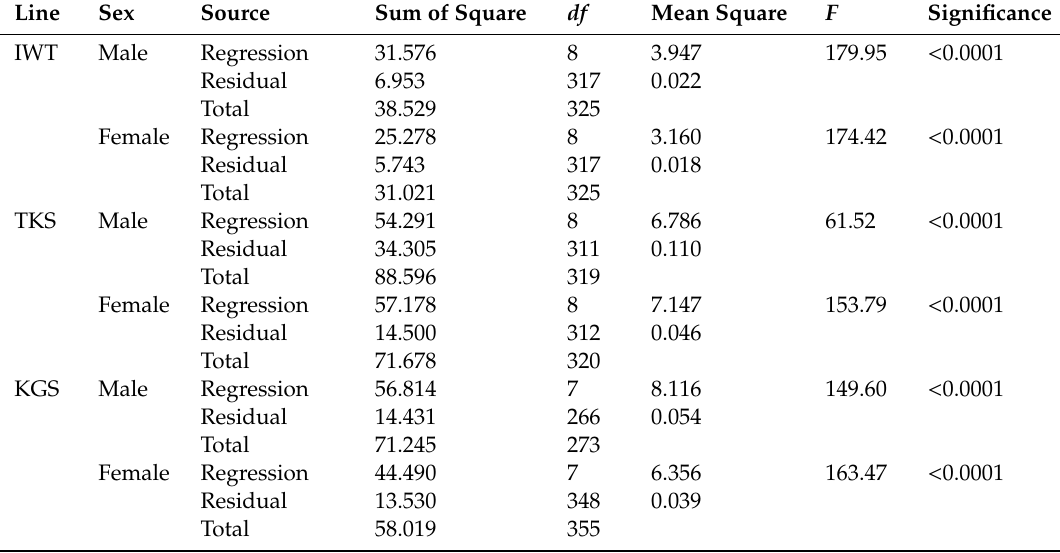
Table 3. ANOVA table of refined models for male and female gametophytes of Undaria pinnatifida . Line Sex Source Sum of Square df Mean